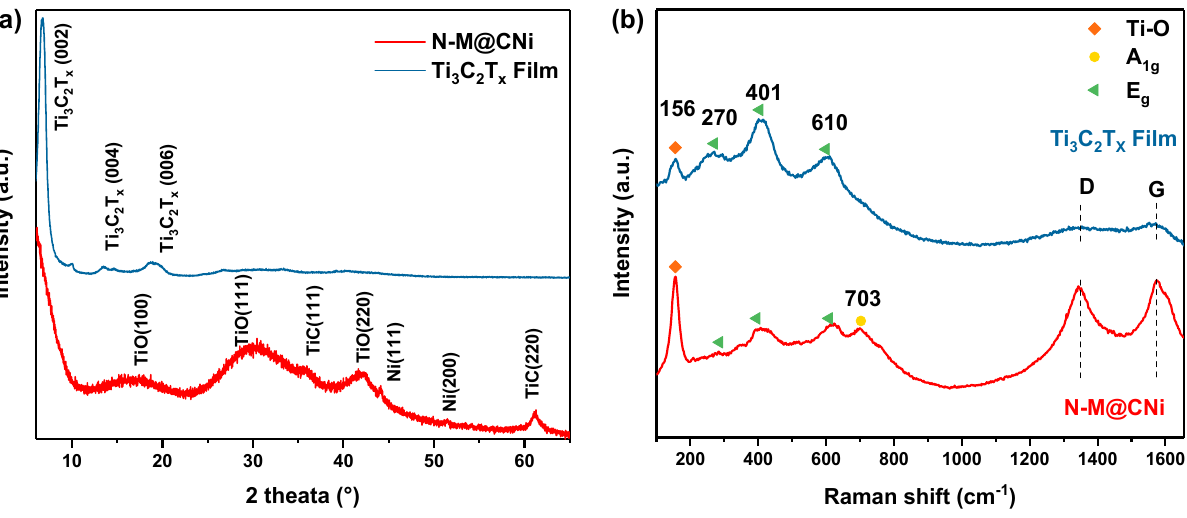
Figure 2. ( a ) XRD patterns and the ( b ) Raman patterns of N-M@CNi powder and Ti 3 C 2 T x film.